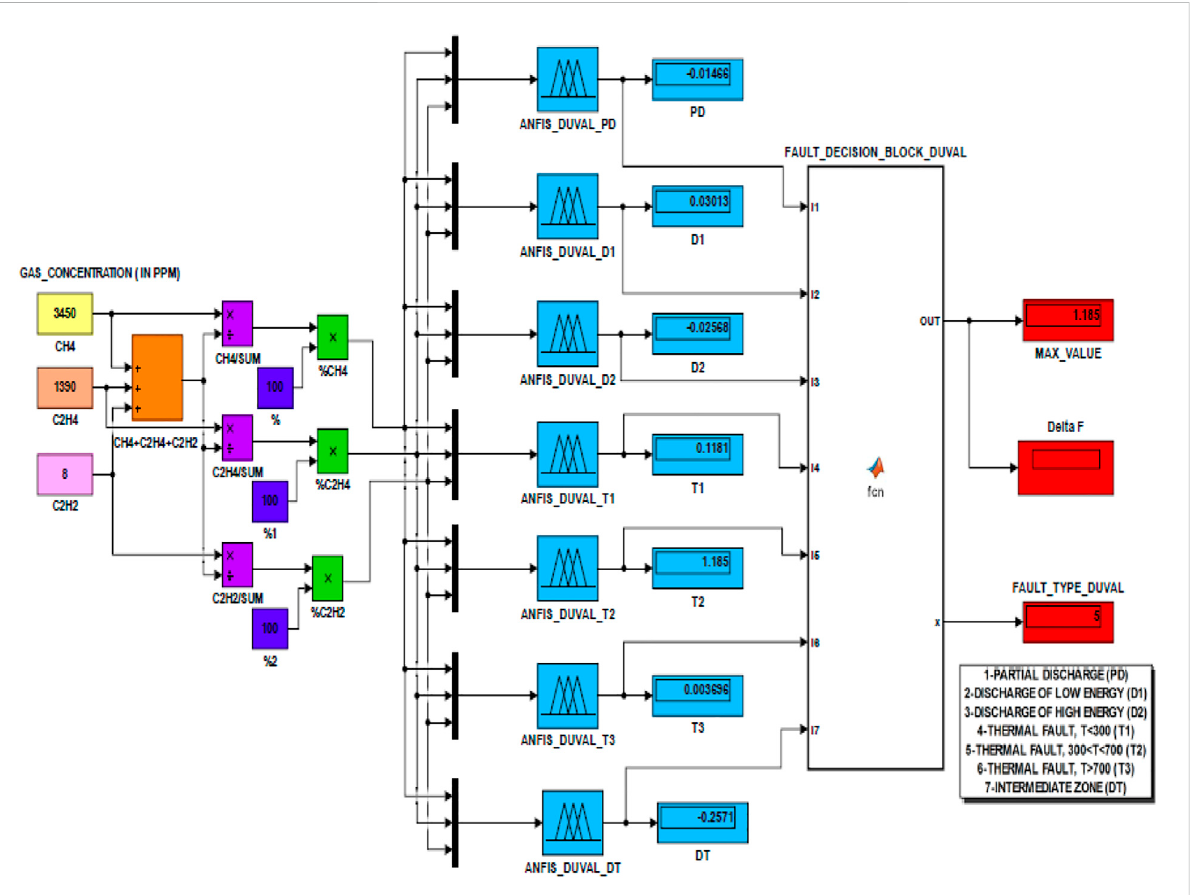
FIGURE 3 MATLAB GUI for ANFIS based implementation of Duval ’ s triangle method.